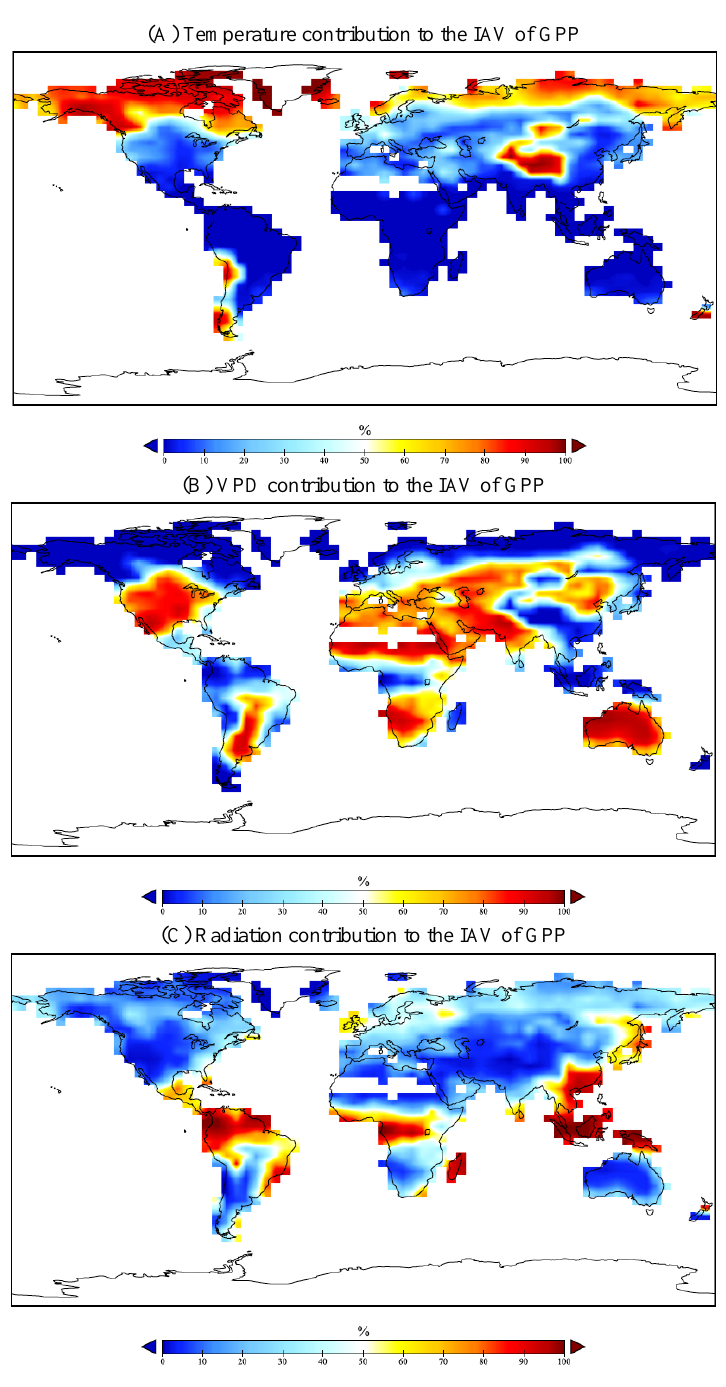
Fig. 10. The global distribution of the relative contribution of each climate variable ( (A) temperature: high values indicate LOW temperature is limiting, (B) vapor pressure deficit (VPD): high value indicate HIGH VPD is limiting , and (C) radiation: high value indicate high LOW radiation is limiting) to the interannual variability (IAV) of